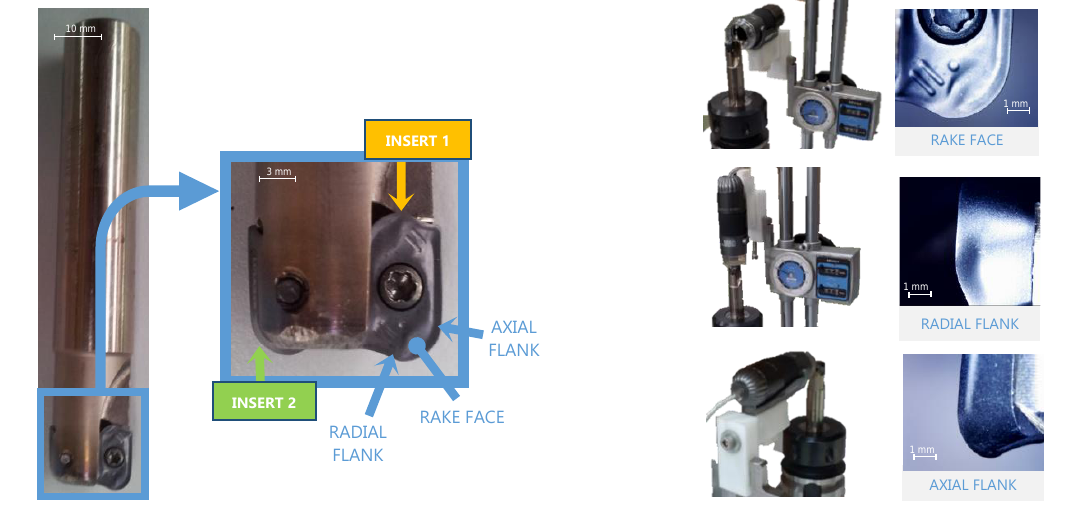
Figure 7. Optical images obtained of the inserts and microscope positioning to take inserts pictures.